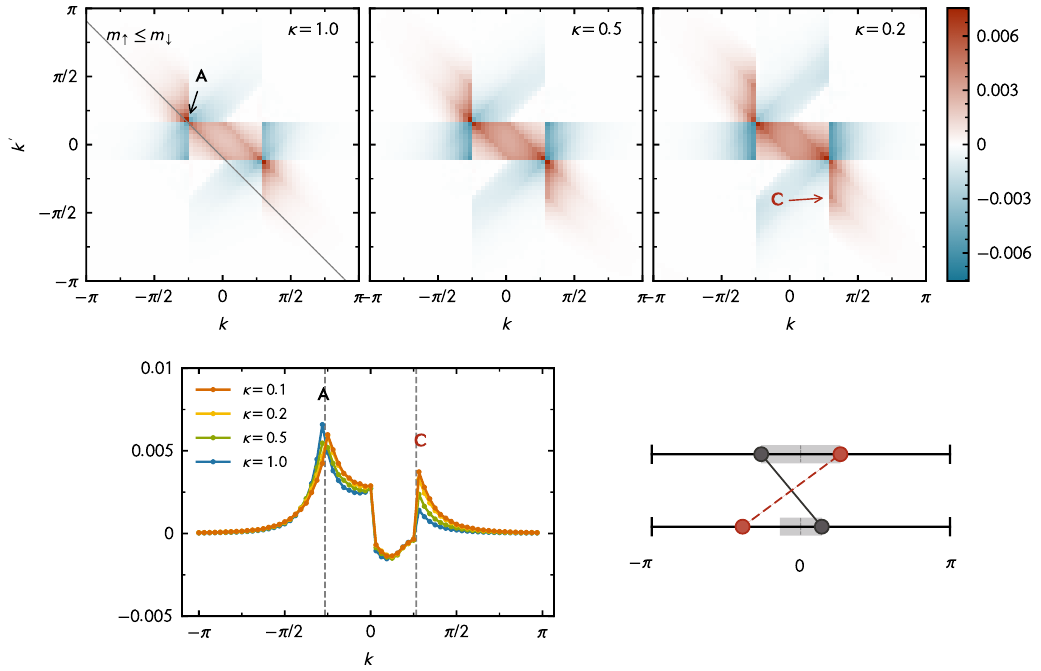
Figure 7: Pairing in heavy-minority systems. Top row panels : Shot-noise correlator G ↑↓ for ( N ↑ , N ↓ ) = ( 17,9 ) particles and mass imbalances κ = 1,0.5 and 0.2 (from left = − q , corresponding to to right). Bottom left panel : Cuts of G ↑↓ along constant k tot the gray dashed line in the upper left panel (the statistical error bars are smaller than the symbol size). The peaks labeled “A” and “C” correspond to the points marked in the upper panels. The vertical gray dashed lines indicate the position of the Fermi ↑ . Bottom right panel : Sketch points associated with the majority species k = ± k F of the pairing mechanism in momentum space. The upper (lower) line depicts the first Brillouin zone of the spin-up (spin-down) species. The end points of the gray- shaded bands correspond to the Fermi points of the two species. Finally, the big black dots connected with a black solid line symbolize standard BCS-type pairing “across the Fermi lines” (gray-shaded bands) which gives rise to peak A. The big red dots connected with a dashed red line symbolize the second most dominant pairing correlation which gives rise to the peak